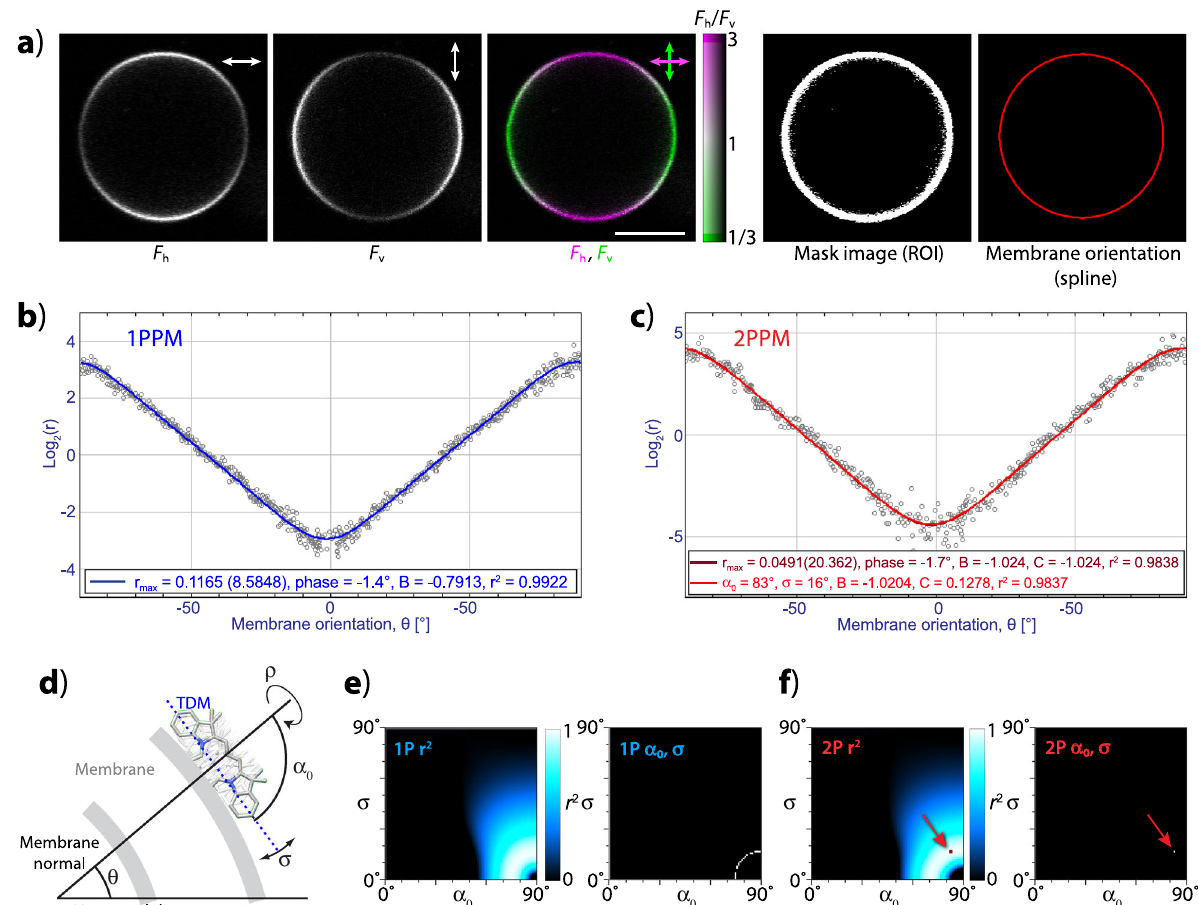
Fig. 3 Quantitative analysis of polarization microscopy images of DiI-stained vesicles. a From left: a vesicle observed with 1P excitation polarized horizontally and vertically, after image processing visualizing LD, a segmentation image de fi ning the pixels of interest, and a spline approximating the vesicle shape. Scale bar: 10 µ m. b 1P LD (expressed as log 2 ( r )) of the vesicle in ( a ), as a function of membrane orientation (angle θ ). The blue line shows a fi t by a parametric function describing 1P LD. c Same as ( b ), but for 2P excitation. The dark-red line shows a fi t of the data by a generic parametric function describing 2P LD. The light-red line is a fi t by a parametric function whose parameters have been restricted to those consistent with a Gaussian distribution of molecular orientations. d Mathematical model used for describing molecular orientation with respect to a membrane by a wrapped Gaussian distribution de fi ned by a mean tilt angle ( α 0 ) and tilt angle distribution width ( σ ). Free rotation along the membrane normal (angle ρ ) is assumed. e Agreement of the 1P LD data shown in ( b ) with different combinations of α 0 and σ . Left: heat-map of goodness of fi t (coef fi cient of determination, r 2 ); right: α 0 , σ combinations consistent with the data. f Same as ( e ), but for 2P LD data shown in ( c ). The best fi t α 0 , σ combination is indicated by an